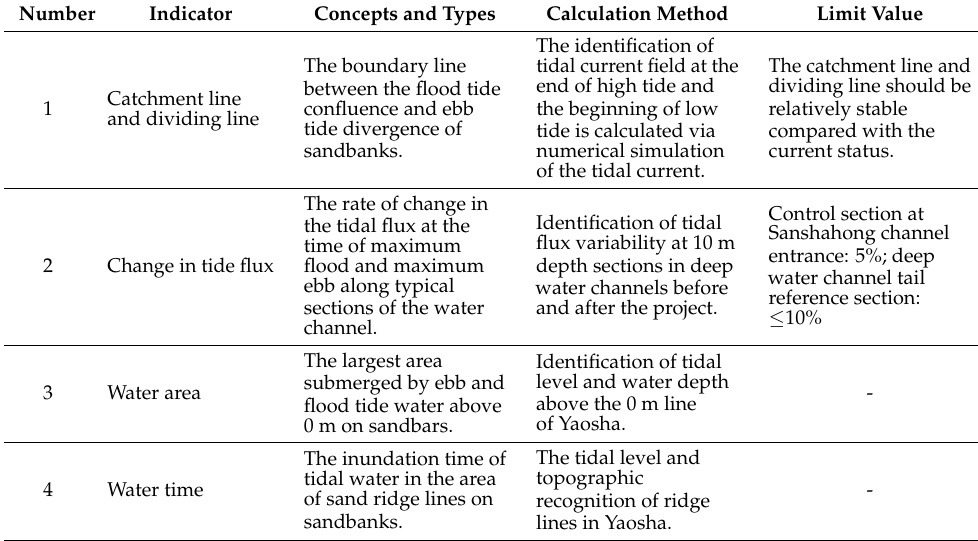
Table 1. Ecological evaluation indexes and standard limit values of